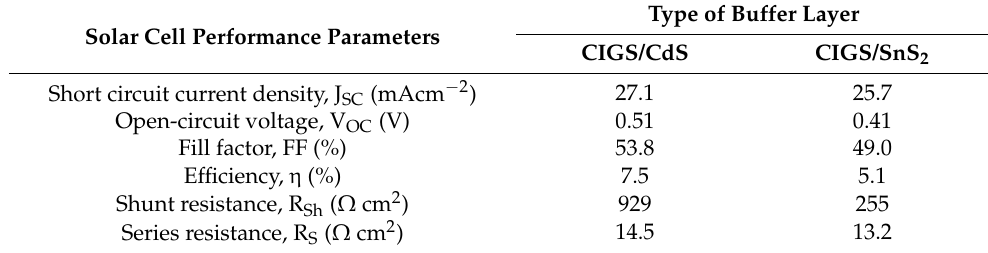
Table 2. Solar cell performance parameters of CIGS devices with conventional CdS and SnS 2